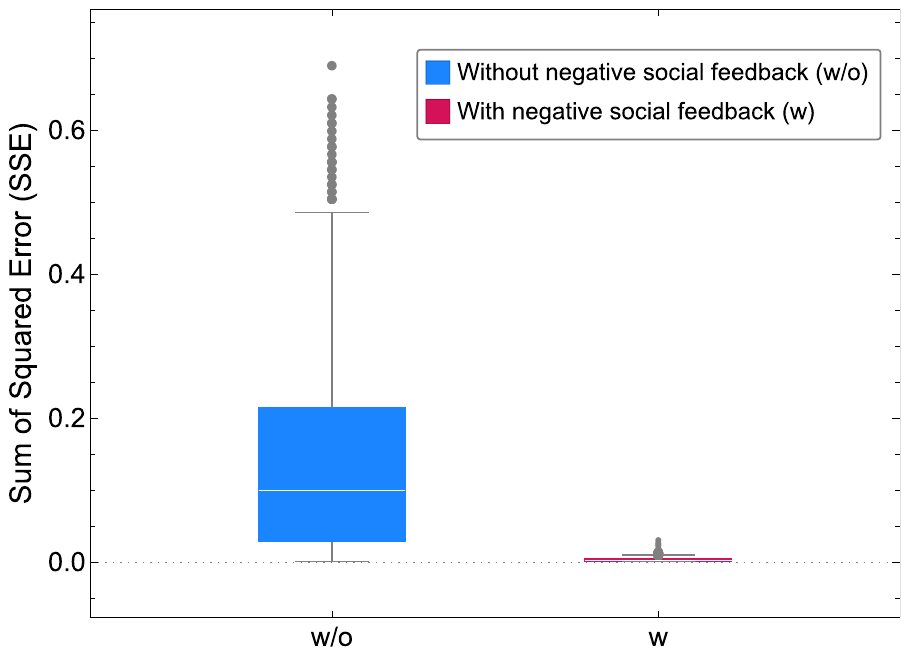
Fig 2. Sum of squared errors (SSE) computed as the sum for n = 2 food patches of the square of the difference between the subpopulation size at time 1000 (convergence) and the target distribution to that patch (see S7 Text). The boxplots show the distribution of the SSE for 10 3 numerical simulations for swarm size S = 200, average recruitment strength r = 100, and qualities q 1 = 0.75 and q 2 =